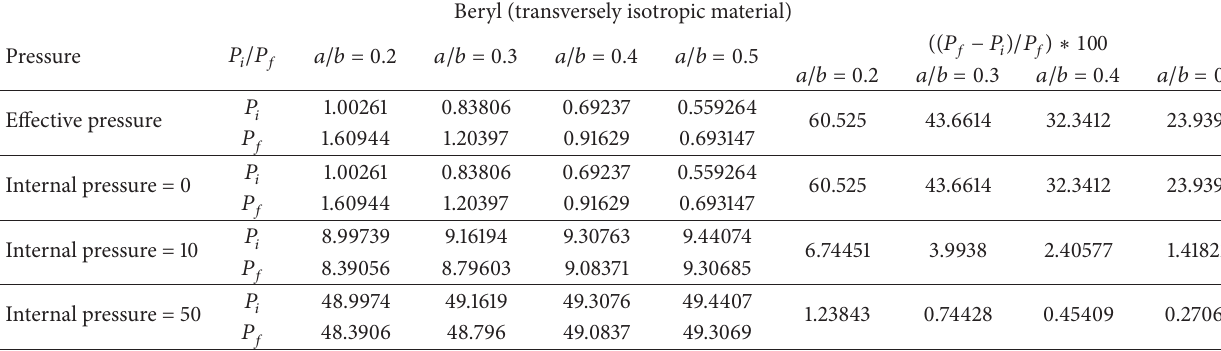
Table 3: The pressure required for initial yielding and fully plastic state for transversely isotropic material (beryl). Beryl (transversely isotropic